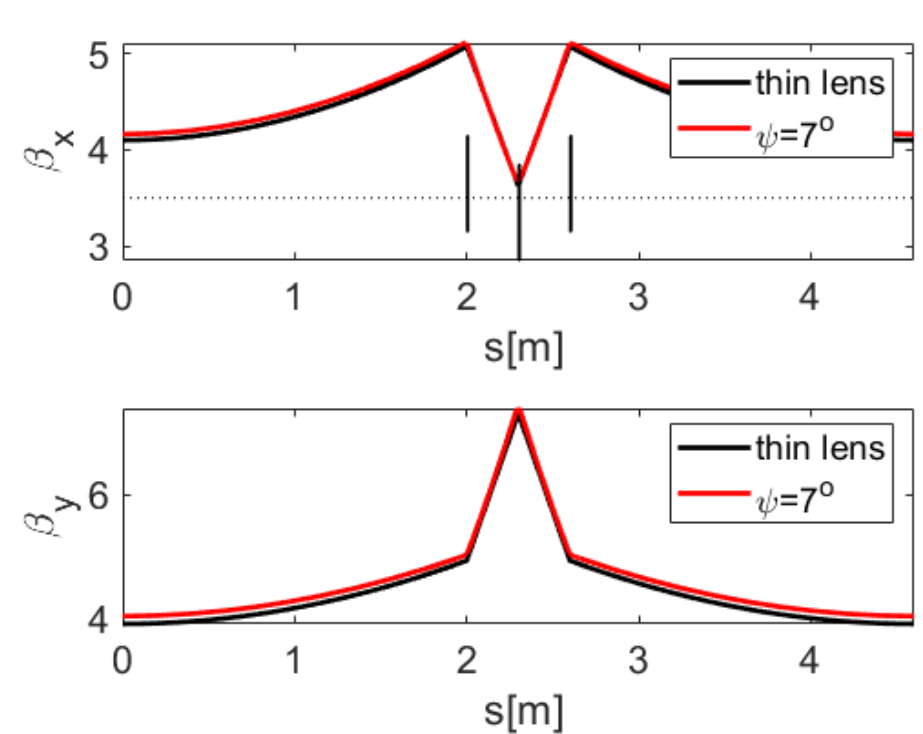
Figure 9. The horizontal (top) and vertical (bottom) beta functions of a cell made of thin-lens quadrupoles (black lines) with 60 ◦ phase advance in both planes. The red lines are the corresponding beta functions where the fields of quadrupole rings from Figure 10 were used, and the central double-ring quadrupole was rotated by ψ = 7 ◦ .